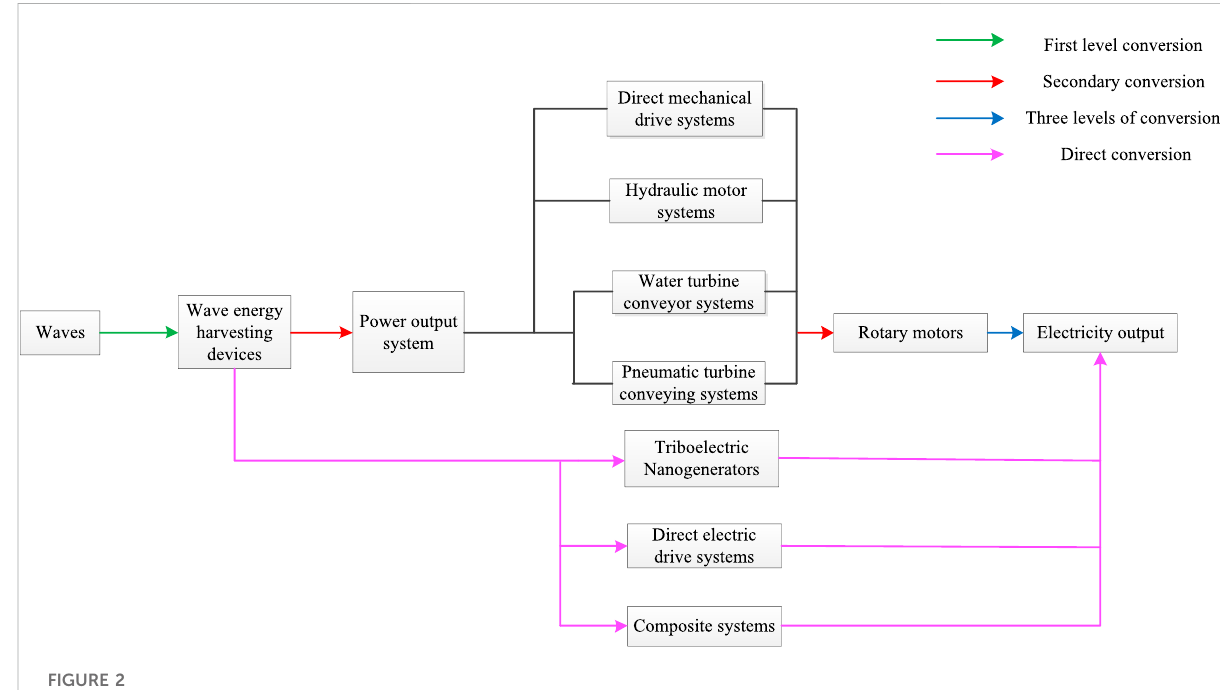
FIGURE 2 Schematic diagram of basic principle of wave energy power